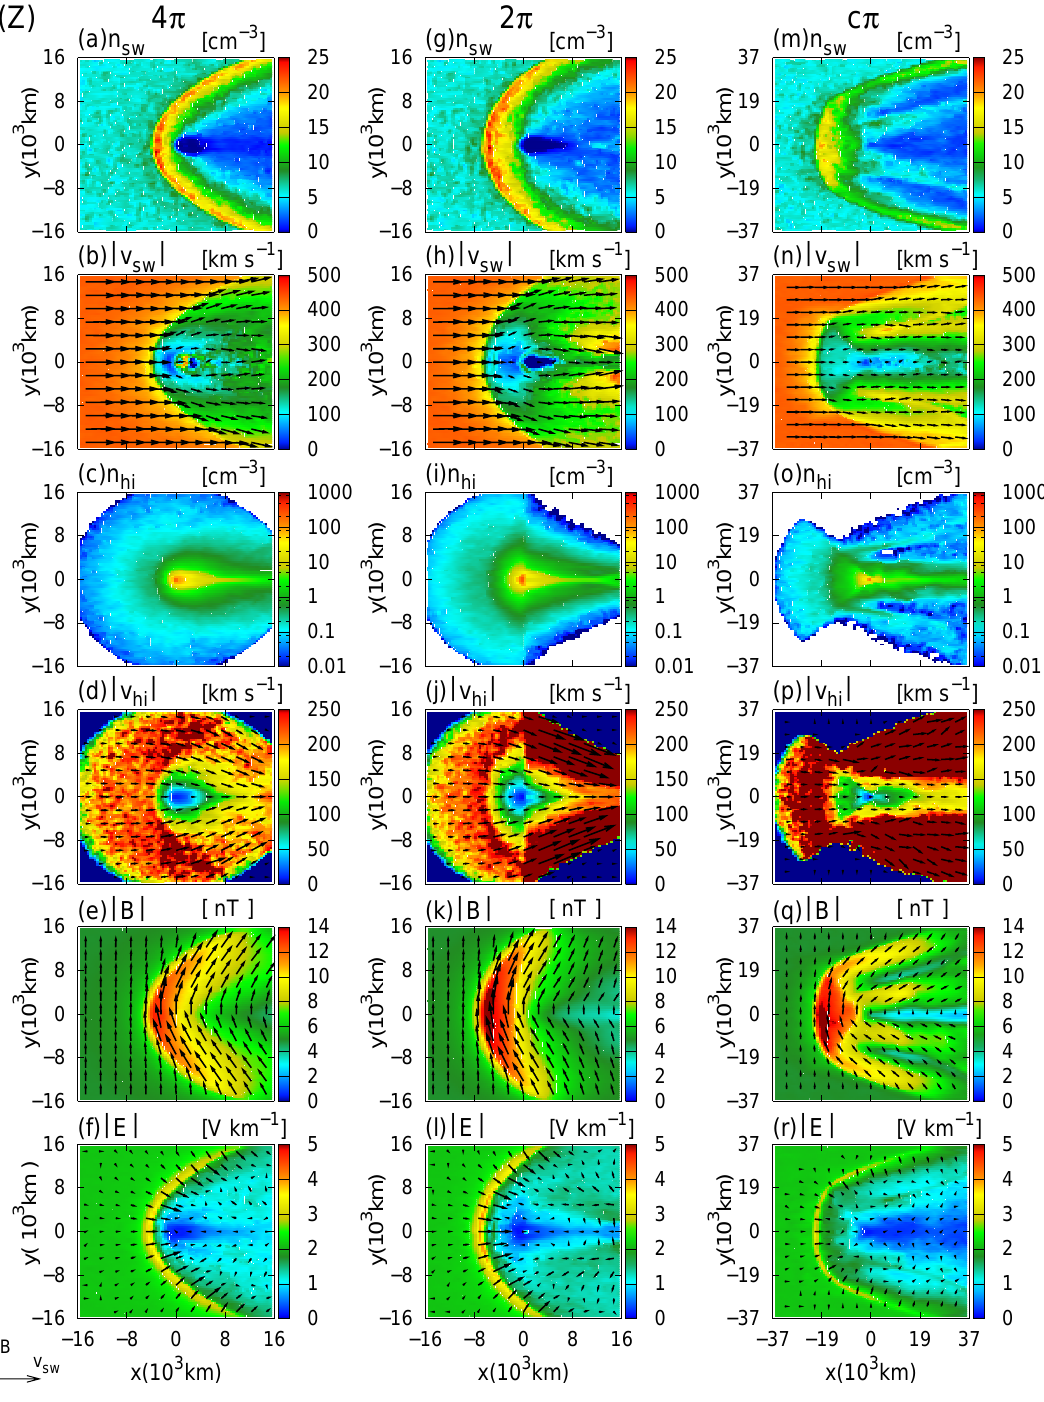
Fig. 7. Cut through the ecliptic plane of the simulation box at 1.30AU. Like in Fig. 6 we show from left to right the spherically symmetric, the day side restricted and the cone shaped model. The solar wind density ( a, g, m ) and bulk velocity ( b, h, n ), the cometary ion density ( c, i, o ) and bulk velocity ( d, j, p ), the magnetic ( e, k, q ) and the electric field ( f, l, r ) are shown. The undisturbed solar wind flow points in +x direction while the interplanetary magnetic field points in +y direction. In general this plane is characterized by its high symmetry with respect to the x-axis. This is the result of being the orthogonal plane of the convective electric field. Increasing spatial confinment leads in both cases, 2 π and c π , to an increase of the mass-loaded region. In the c π case, however, this region increases substantially compared to the 4 π case. As a consequence the deceleration of the solar wind flow occurs much smoother. This is clearly visible when comparing (b) with (n). In addition, it leads to a MBR, shown in (q), which covers a larger area. Notice the larger spatial scale in case of the c π